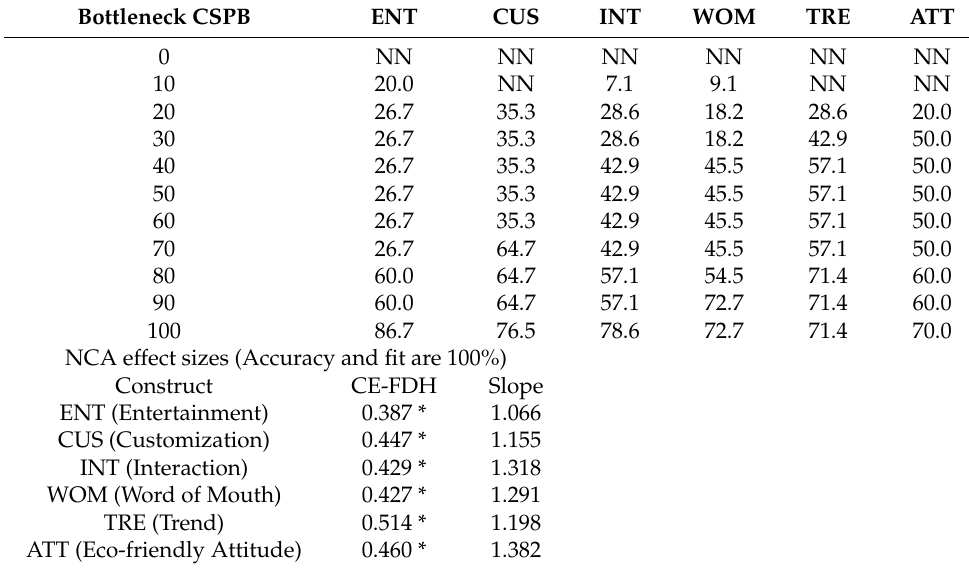
Table 5. Bottleneck table and NCA effect